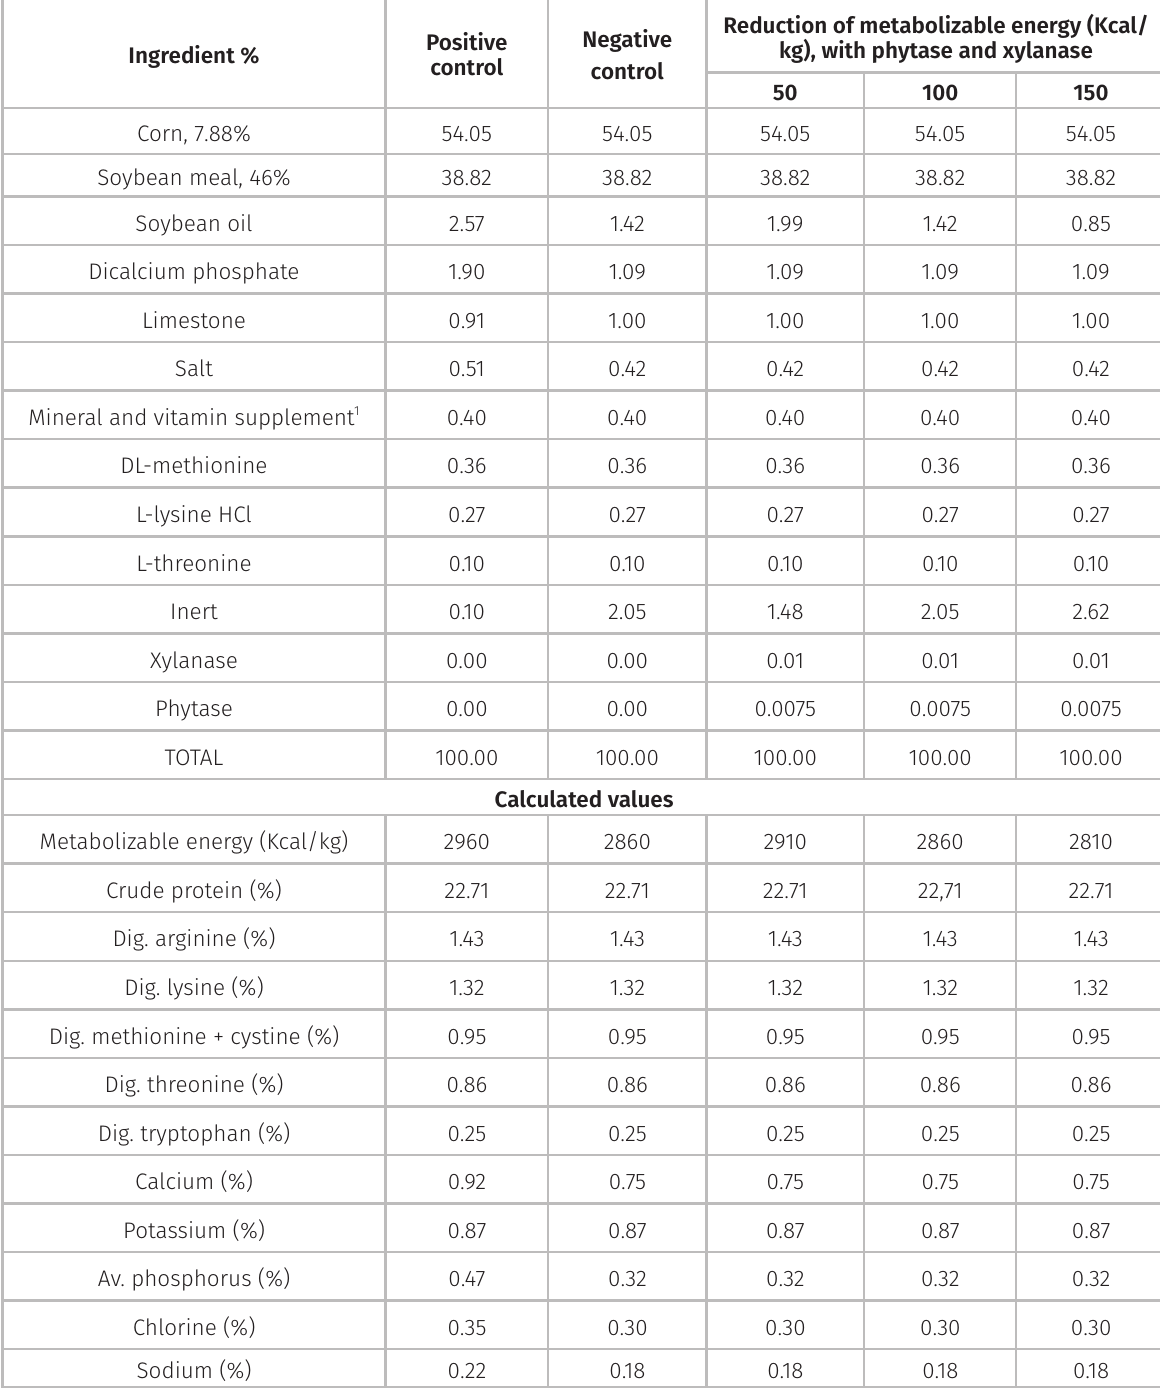
Table I. Centesimal and calculated compositions of experimental diets for broilers in the pre-starter phase (1 to 7 days). Ingredient %